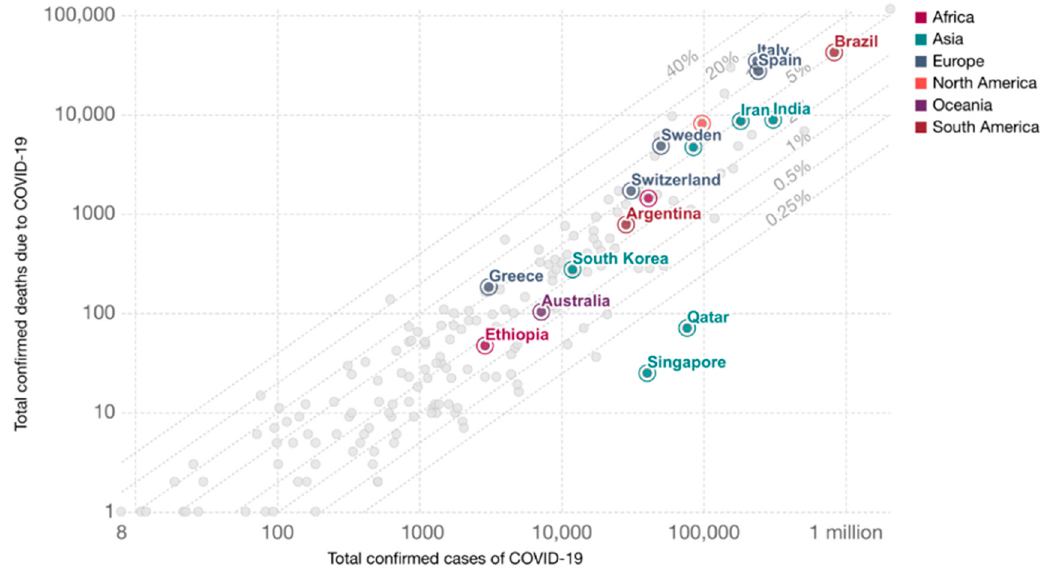
Figure 1. Total confirmed coronavirus disease 2019 (COVID-19) deaths vs. cases (13 June 2020).